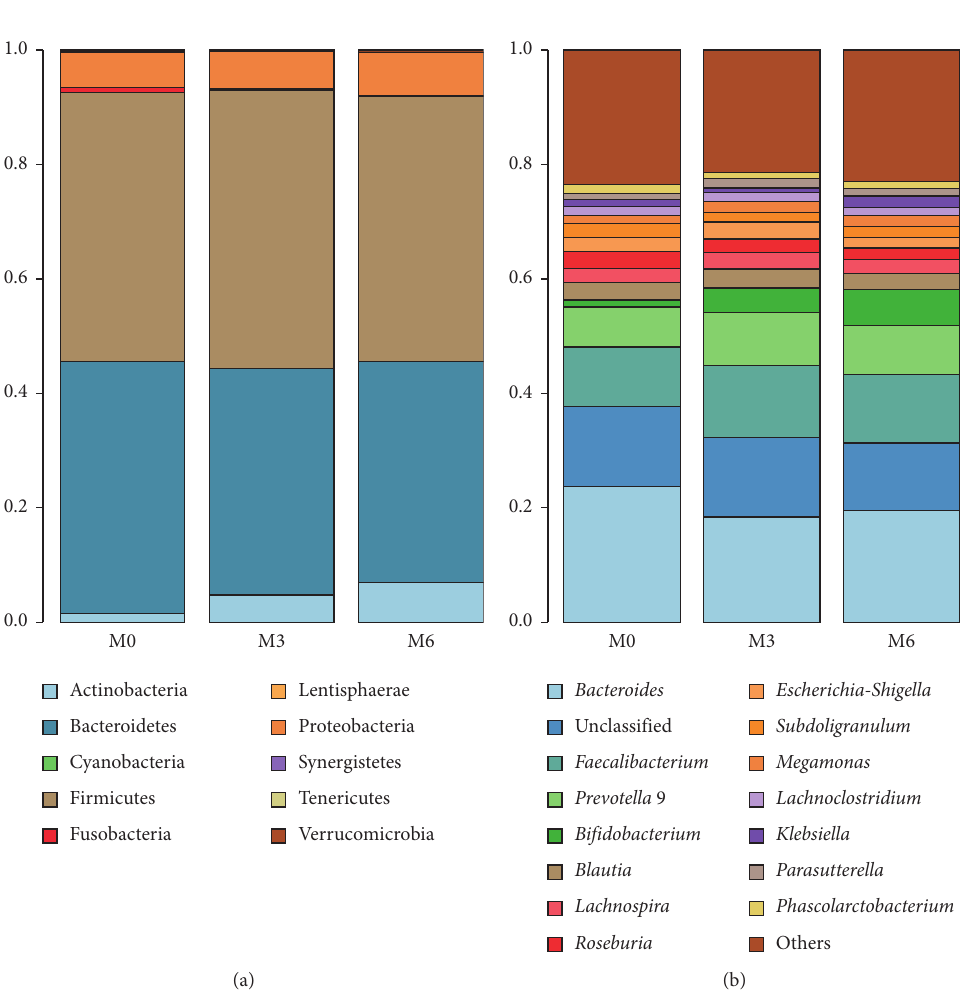
Figure 2: The relative abundance of bacteria at the phylum level (a) and genus level (b) before and after inulin supplement. M0, baseline; M3, at three months after inulin intervention; M6, at six months after inulin